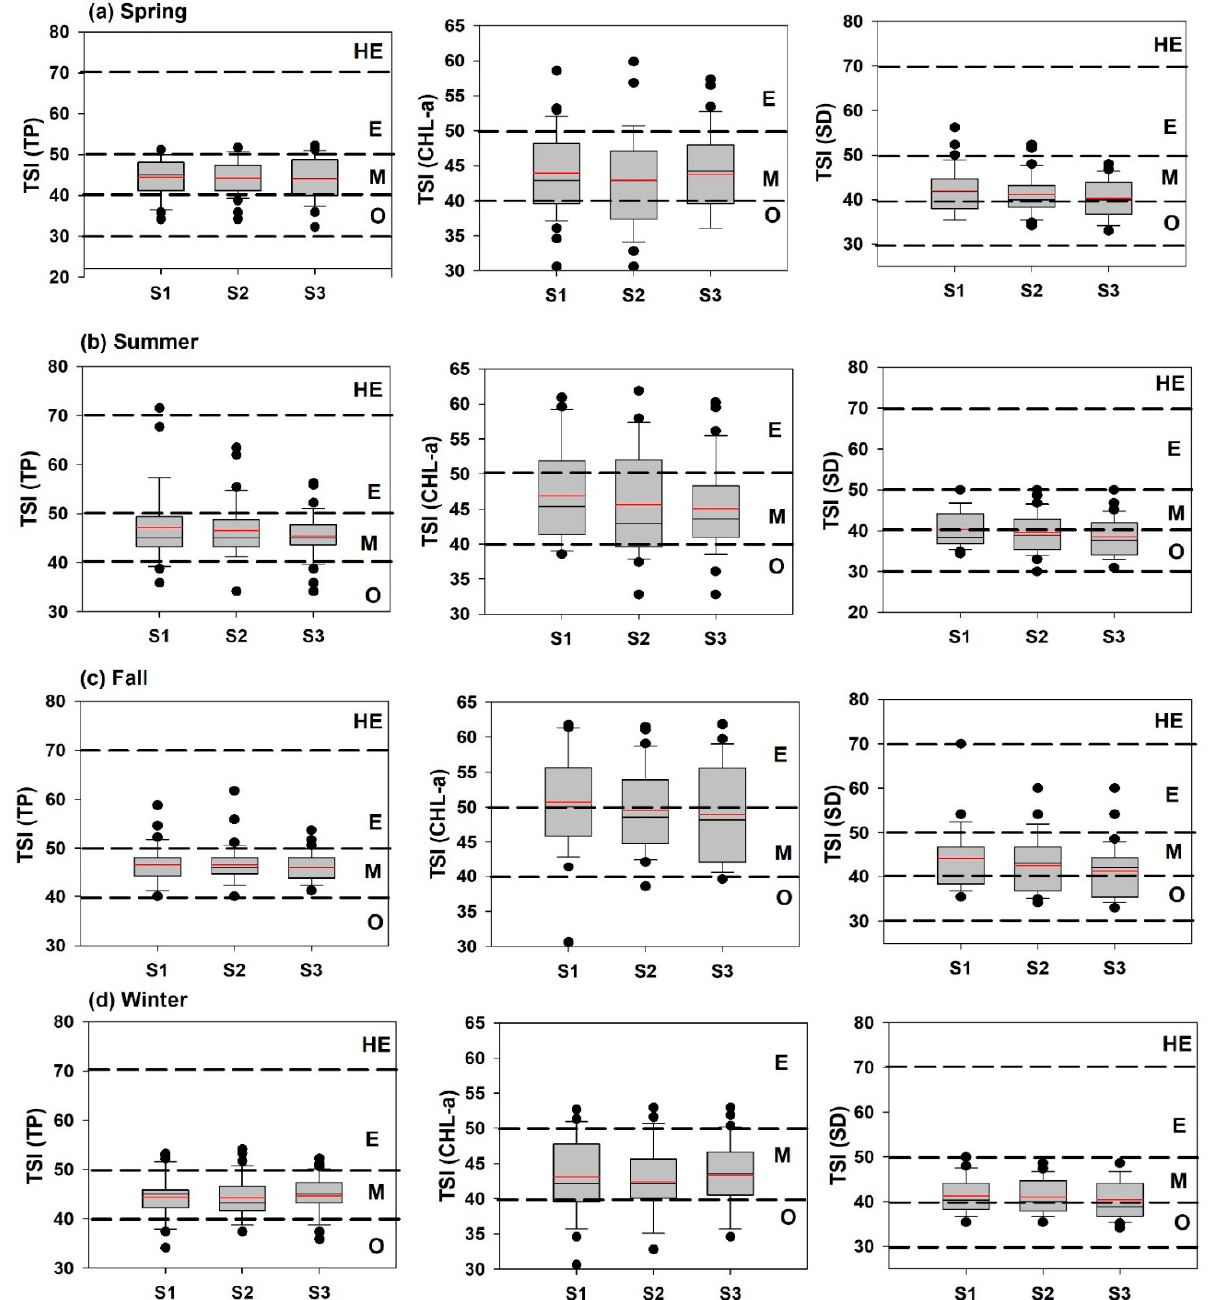
Figure 10. Seasonal variations of the trophic state index (TSI) of Andong Reservoir. (spring: March–May; summer: June– August; autumn: September–November, and winter: December–February; O: oligotrophic; M: mesotrophic; E: eutrophic, and HE: hypereutrophic).